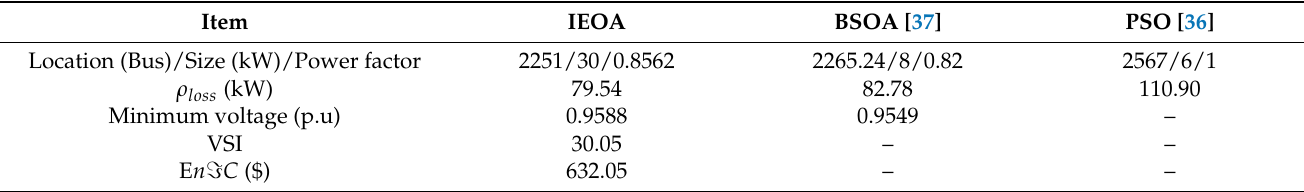
Table 4. Results comparison of the IEOA with the last methods in DMM-based problem